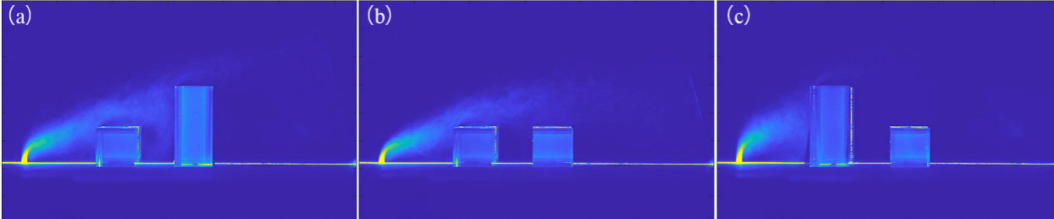
Figure 19. Time-averaged concentration fields on the vertical plane (y = 0) with different height ratios streets: ( a ) R H = 2.0; ( b ) R H = 1.0; ( c ) R H = 0.5.